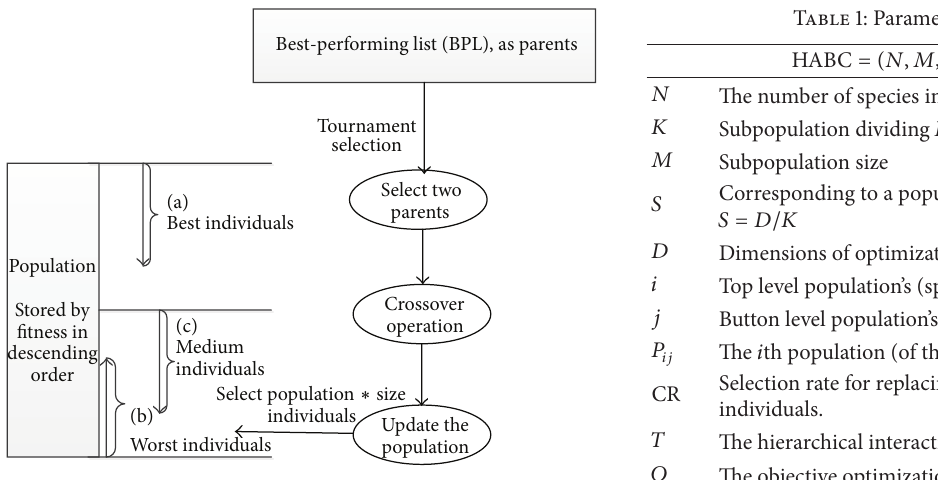
Figure 2: The information exchange mechanism based on crossover operation.